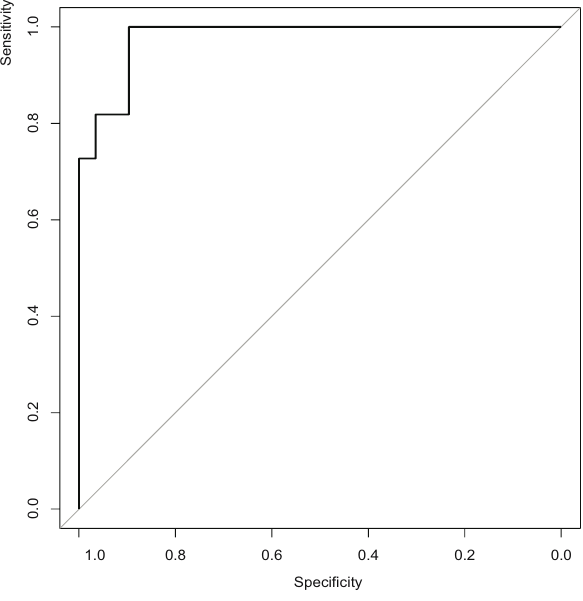
Figure 1: ROC curve of predicting postoperative dyspnea.